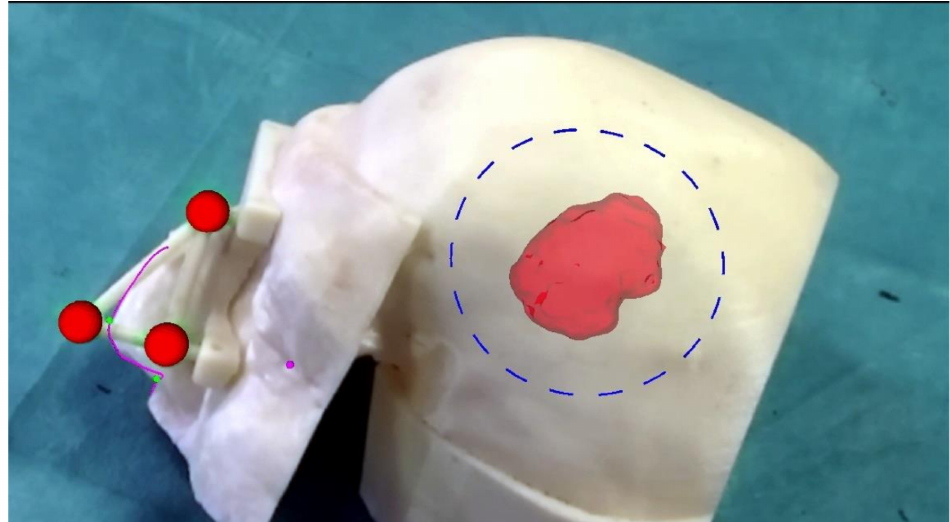
Figure 6. Augmented reality scene with 3D reconstruction of the meningioma (the semi-transparent red structure), the planned craniotomy (the blue dashed line), the optical markers (the red spheres), the reference landmarks (the small pink and green spheres) and the nose profile (the pink line). The last two virtual elements are used as reference landmarks to verify the accuracy of the image-to-patient registration. The ideal pre-operative and intra-operative procedural steps are outlined in Figure